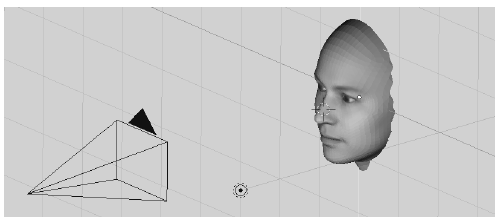
Figure 3. Visibility modelling in Blender